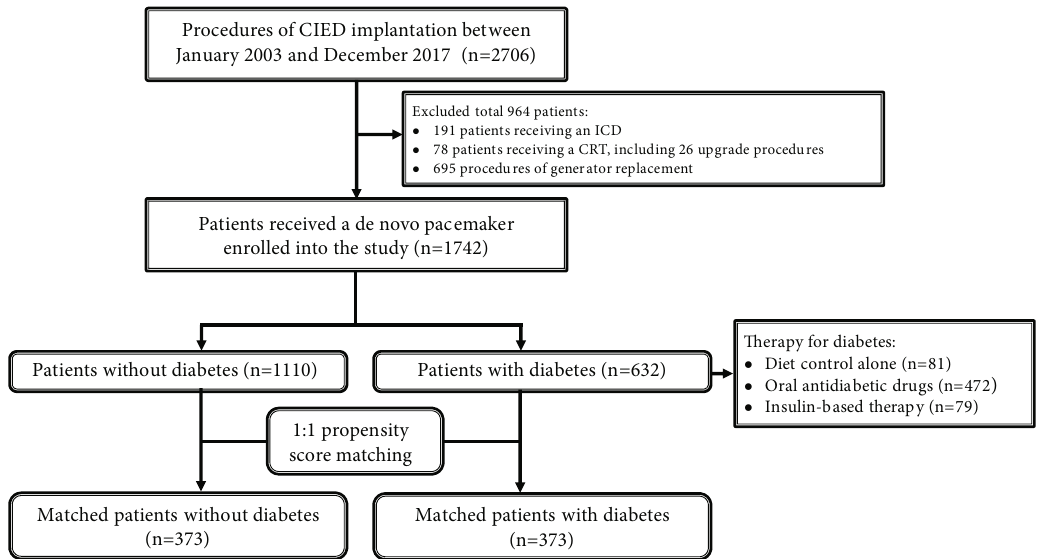
Figure 1: Flow chart of enrollment of patients receiving cardiac implantable electronic devices. CIED: cardiac implantable electronic devices; ICD: implantable cardioverter-de fi brillator; CRT: cardiac resynchronization